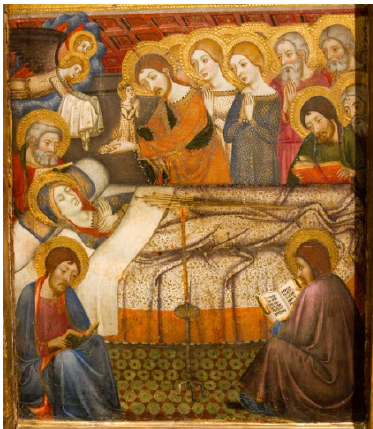
Figure 11. Jaume Serra, “Dormition”, Altarpiece of the Virgin of the Commendator , 1367–1381, Museu Nacional d’Art de Catalunya (MNAC).